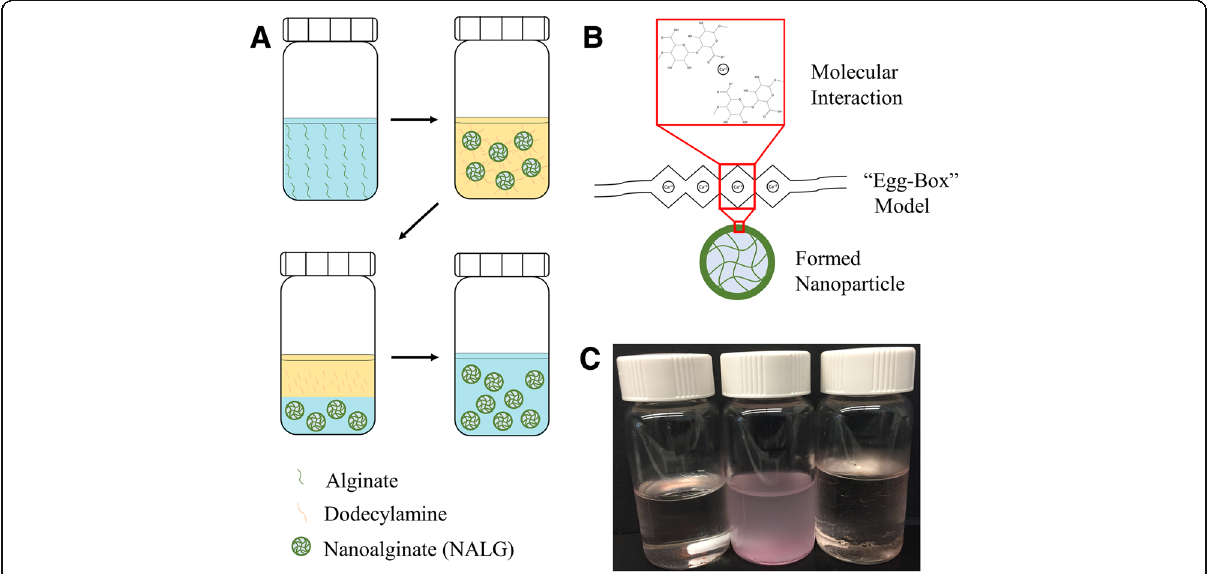
Fig. 1 Formulation process for formation of NALG and NALG-DOX. a Schematic representation of inverse micelle synthesis process. Aqueous alginate chains are crosslinked in organic bath (top), extracted to an aqueous phase (bottom left), then filtered for purification (bottom right). b Molecular interaction of Ca 2+ crosslinking, leading to formed NALG. c Photograph of synthesis at various points, from left to right, emulsion before CaCl 2 addition, emulsion after CaCl 2 addition, and separation upon addition of